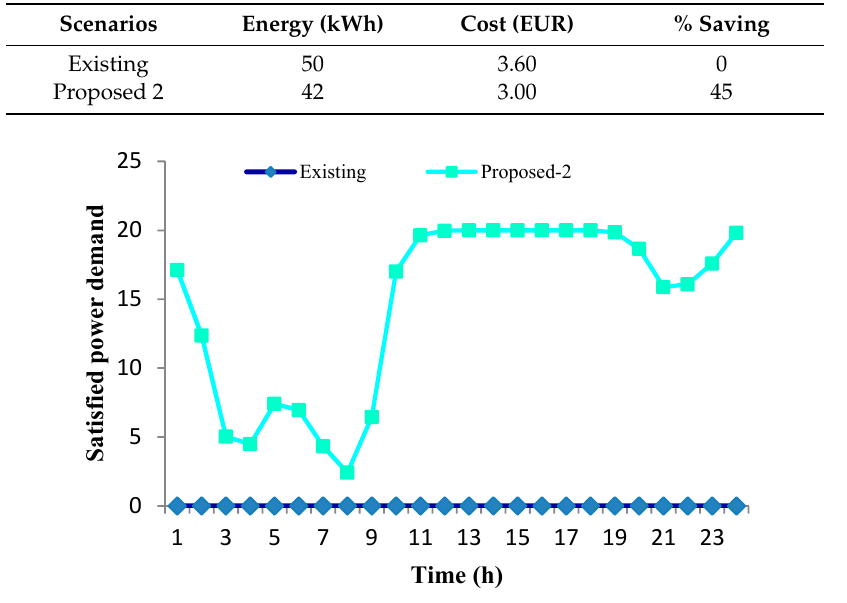
Figure 14. Comparison of satisfied power demand management between proposed-2 and existing scenario over 24 h time horizon. Table 5. Comparison of the proposed and existing satisfied power demand management for